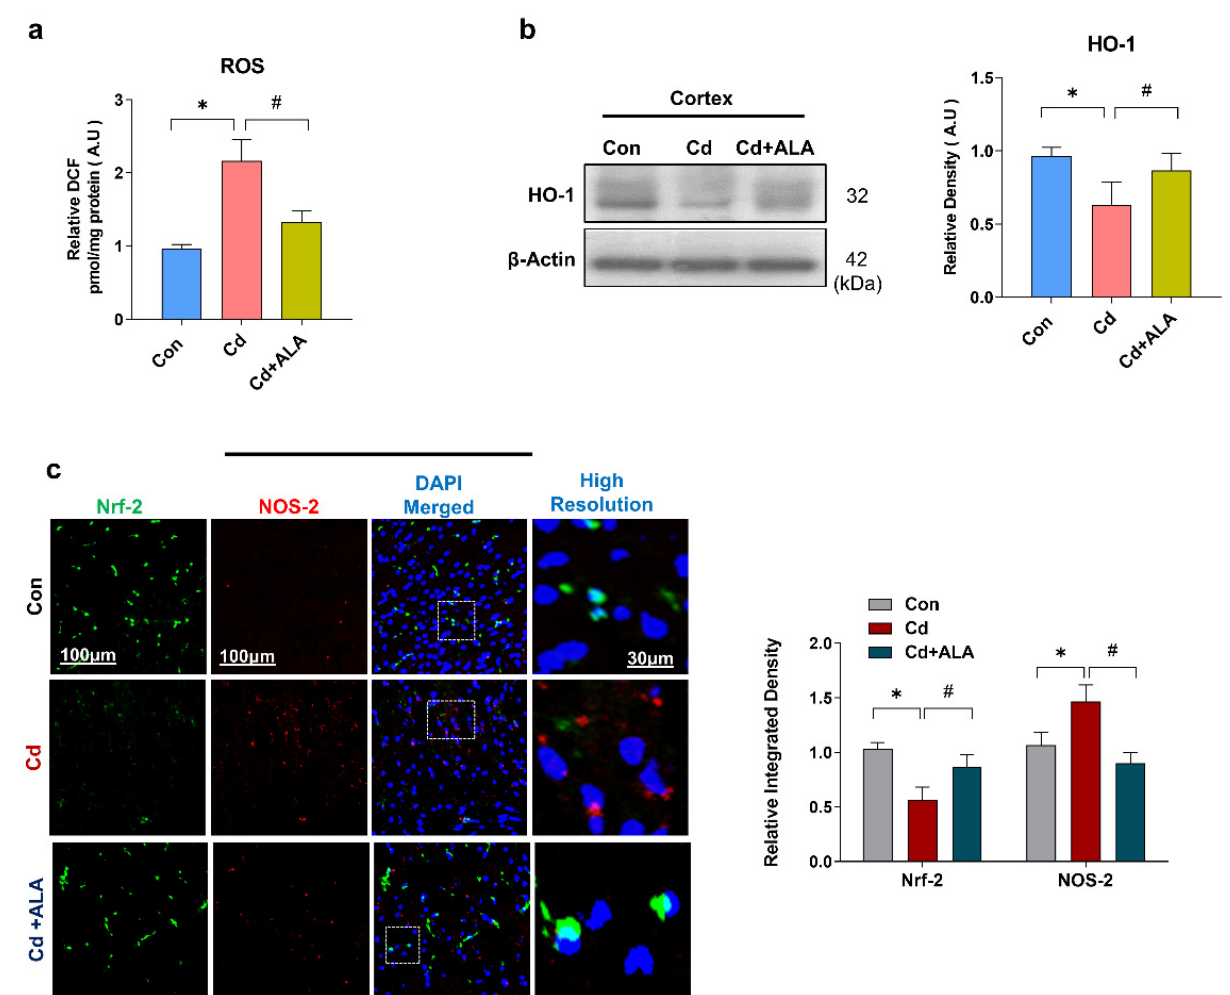
Figure 1. ALA regulates the level of the antioxidant system via Nrf2/HO-1 signaling. ( a ) Representative is the result of ROS; ( b ) immunoblot for the expression level of HO-1 in mouse brain ( n = 5 mice per group; the number of experiments = 3; statistical analysis of one-way ANOVA with Tukey’s posthoc test was used for comparisons among the different groups; ( c ) double immunofluorescence result showing the expression level of Nrf2 and NOS-2 protein molecules. Magnification 10 × , scale bar 100 um, and high resolution. Significantly different from the vehicle-treated control group, #, significantly different from the Cd-treated mouse group. Significance: * p < 0.05; # p < 0.05.